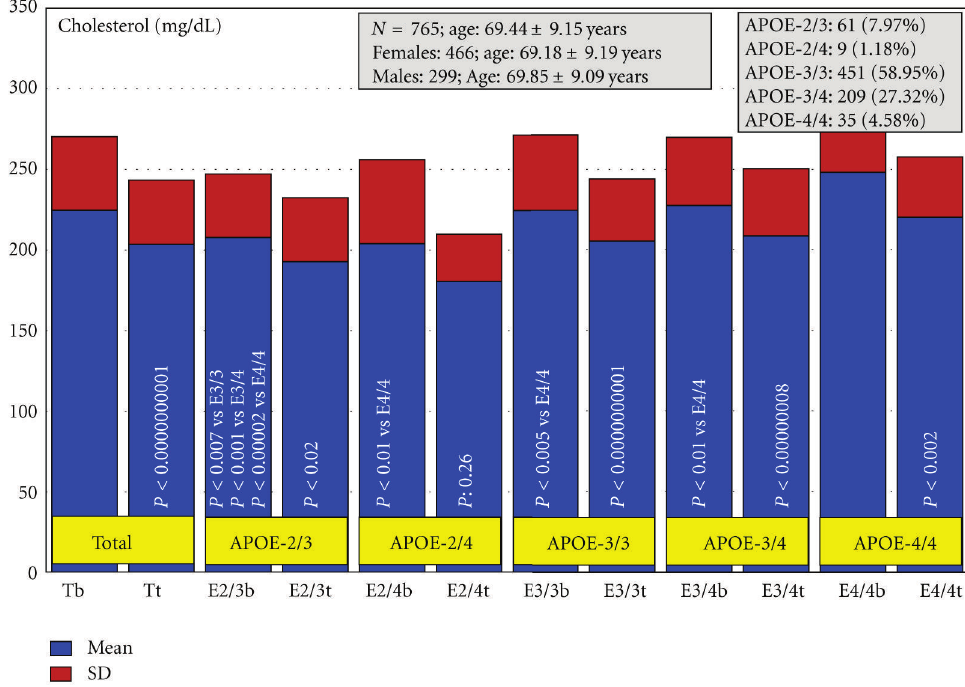
Figure 4: APOE -related changes in total cholesterol levels in patients with dementia treated with E-SAR-94010. Tb: basal total cholesterol (CHO) levels prior to treatment; Tt: CHO levels after 3 months of treatment in the total sample. E2/3b: basal CHO levels in APOE-2/3 carriers; E2/3t: CHO levels after treatment in APOE-2/3 carriers; E2/4b: basal CHO levels in APOE-2/4 carriers; E2/4t: CHO levels after treatment in APOE-2/4 carriers; E3/3b: basal CHO levels in APOE-3/3 carriers; E3/3t: CHO levels after treatment in APOE-3/3 carriers; E3/4b: basal CHO levels in APOE-3/4 carriers; E3/4t: CHO levels after treatment in APOE-3/4 carriers; E4/4b: basal CHO levels in APOE-4/4 carriers; E4/4: CHO levels after treatment in APOE-4/4